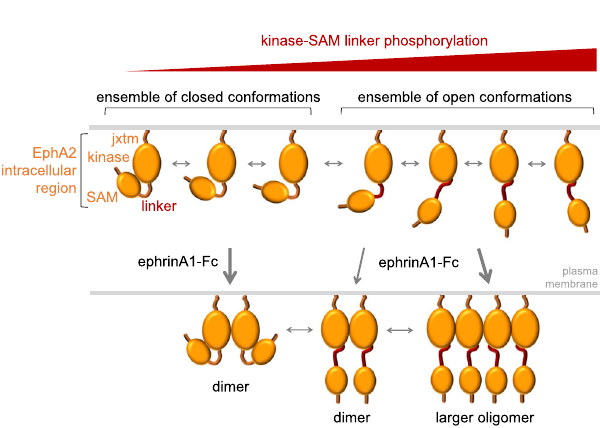
Fig. 7 Multiple kinases phosphorylate the fi ve serine/threonine residues in the EphA2 kinase-SAM linker. a Screen of 298 kinases using in vitro kinase reactions with [ γ - 33 P] ATP and a peptide substrate containing S892, T898, S899, S901 and phosphorylated S897 identi fi es many kinases that phosphorylate residues other than S897. The 44 kinases (15% of those screened) mediating the highest 33 P incorporation are shown in red. b The 24 kinases mediating the highest 33 P incorporation (>50,000 CPM) are shown in red and other less active family members that were also tested are shown in gray. Kinase families are ordered based on the most active family member. c CK1 family members preferentially phosphorylate the peptide with phosphorylated S897 compared to two peptides with Ala replacing S897 and differing in the last residue (averaged together). d Comparison of two peptides containing S892 and differing in the last residue (averaged together) with a peptide in which S892 is replaced by Ala shows that many of the kinases identi fi ed in the screen mainly phosphorylate S892. Kinase families are ordered as in b . e Comparison of the phosphorylation of the two indicated peptides identi fi es kinases that can phosphorylate T898 and/or S899 in the presence or absence of prior S892, S897 and S901 phosphorylation. f 33 P incorporation into peptides in which only S897 can be phosphorylated identi fi es kinase families that can phosphorylate this residue. Higher 33 P incorporation into the peptide also containing the other four serine/threonine residues and residual 33 P incorporation into the peptide with already phosphorylated S897 suggest that some of the kinases can also phosphorylate other residues. Individual data points in c and d (for the measurements with two peptides differing only in the last residue) and in e (for duplicate measurements with CK2 kinases, PLK3, MAP3K9 and CAMK2B) are shown as gray dots. CPM, counts per minute measuring incorporated 33 P; RLU, relative light units. Graphs were generated using Prism software (GraphPad). Source data for the in vitro kinase reactions are provided in Supplementary Table 3.